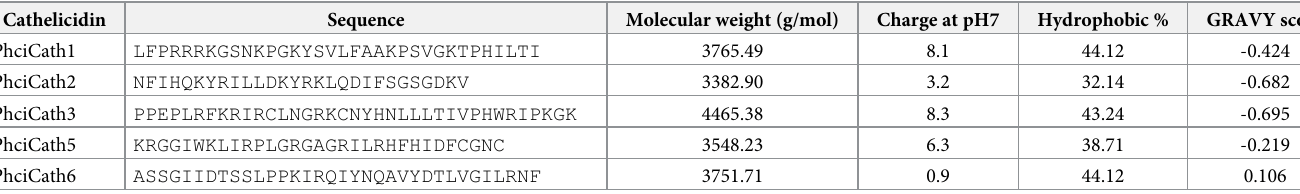
Table 1. Physiochemical properties of predicted mature peptides from full-length koala cathelicidins. Cathelicidin Sequence Molecular weight (g/mol) Charge at pH7 Hydrophobic % GRAVY score PhciCath1 LFPRRRKGSNKPGKYSVLFAAKPSVGKTPHILTI 3765.49 8.1 44.12 -0.424 PhciCath2 NFIHQKYRILLDKYRKLQDIFSGSGDKV 3382.90 3.2 32.14 -0.682 PhciCath3 PPEPLRFKRIRCLNGRKCNYHNLLLTIVPHWRIPKGK 4465.38 8.3 43.24 -0.695 PhciCath5 KRGGIWKLIRPLGRGAGRILRHFHIDFCGNC 3548.23 6.3 38.71 -0.219 PhciCath6 ASSGIIDTSSLPPKIRQIYNQAVYDTLVGILRNF 3751.71 0.9 44.12 0.106 All five mature peptides are of a similar molecular weight, and most display a high cationic charge at pH 7. The percentage of hydrophobic amino acids and grand average of hydropathicity (GRAVY) score for each mature peptide is also presented. The GRAVY score measures the hydrophilicity or hydrophobicity of a peptide, with negative and positive scores indicating a hydrophilic and hydrophobic peptide